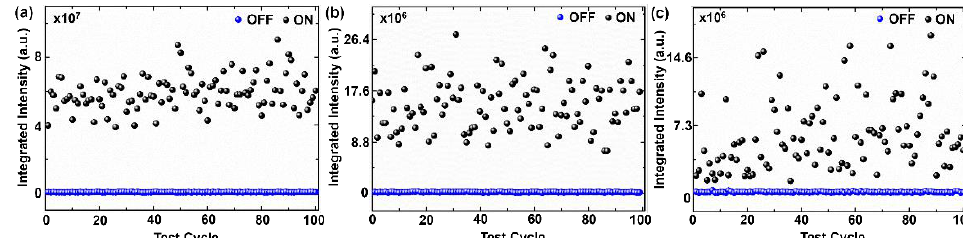
Figure 3. Regulation effect of scattering feedback on the intensity of random lasing. ( a ) The integral intensity evolution of the emission spectra when the RL B is in ON state (black) or OFF state (blue) under a pump power density of 0.62 MW cm −2 . ( b ) The integral intensity evolution of the emission spectra when the RL G is in ON state (black) or OFF state (blue) at 1.39 MW cm −2 . ( c ) The integral intensity evolution of the emission spectra when the RL R is in ON state (black) or OFF state (blue) at 1.46 MW cm −2 . The corresponding integral range is (440, 470) nm for RL B , (510, 570) nm for RL G and (625, 700) nm for RL R .